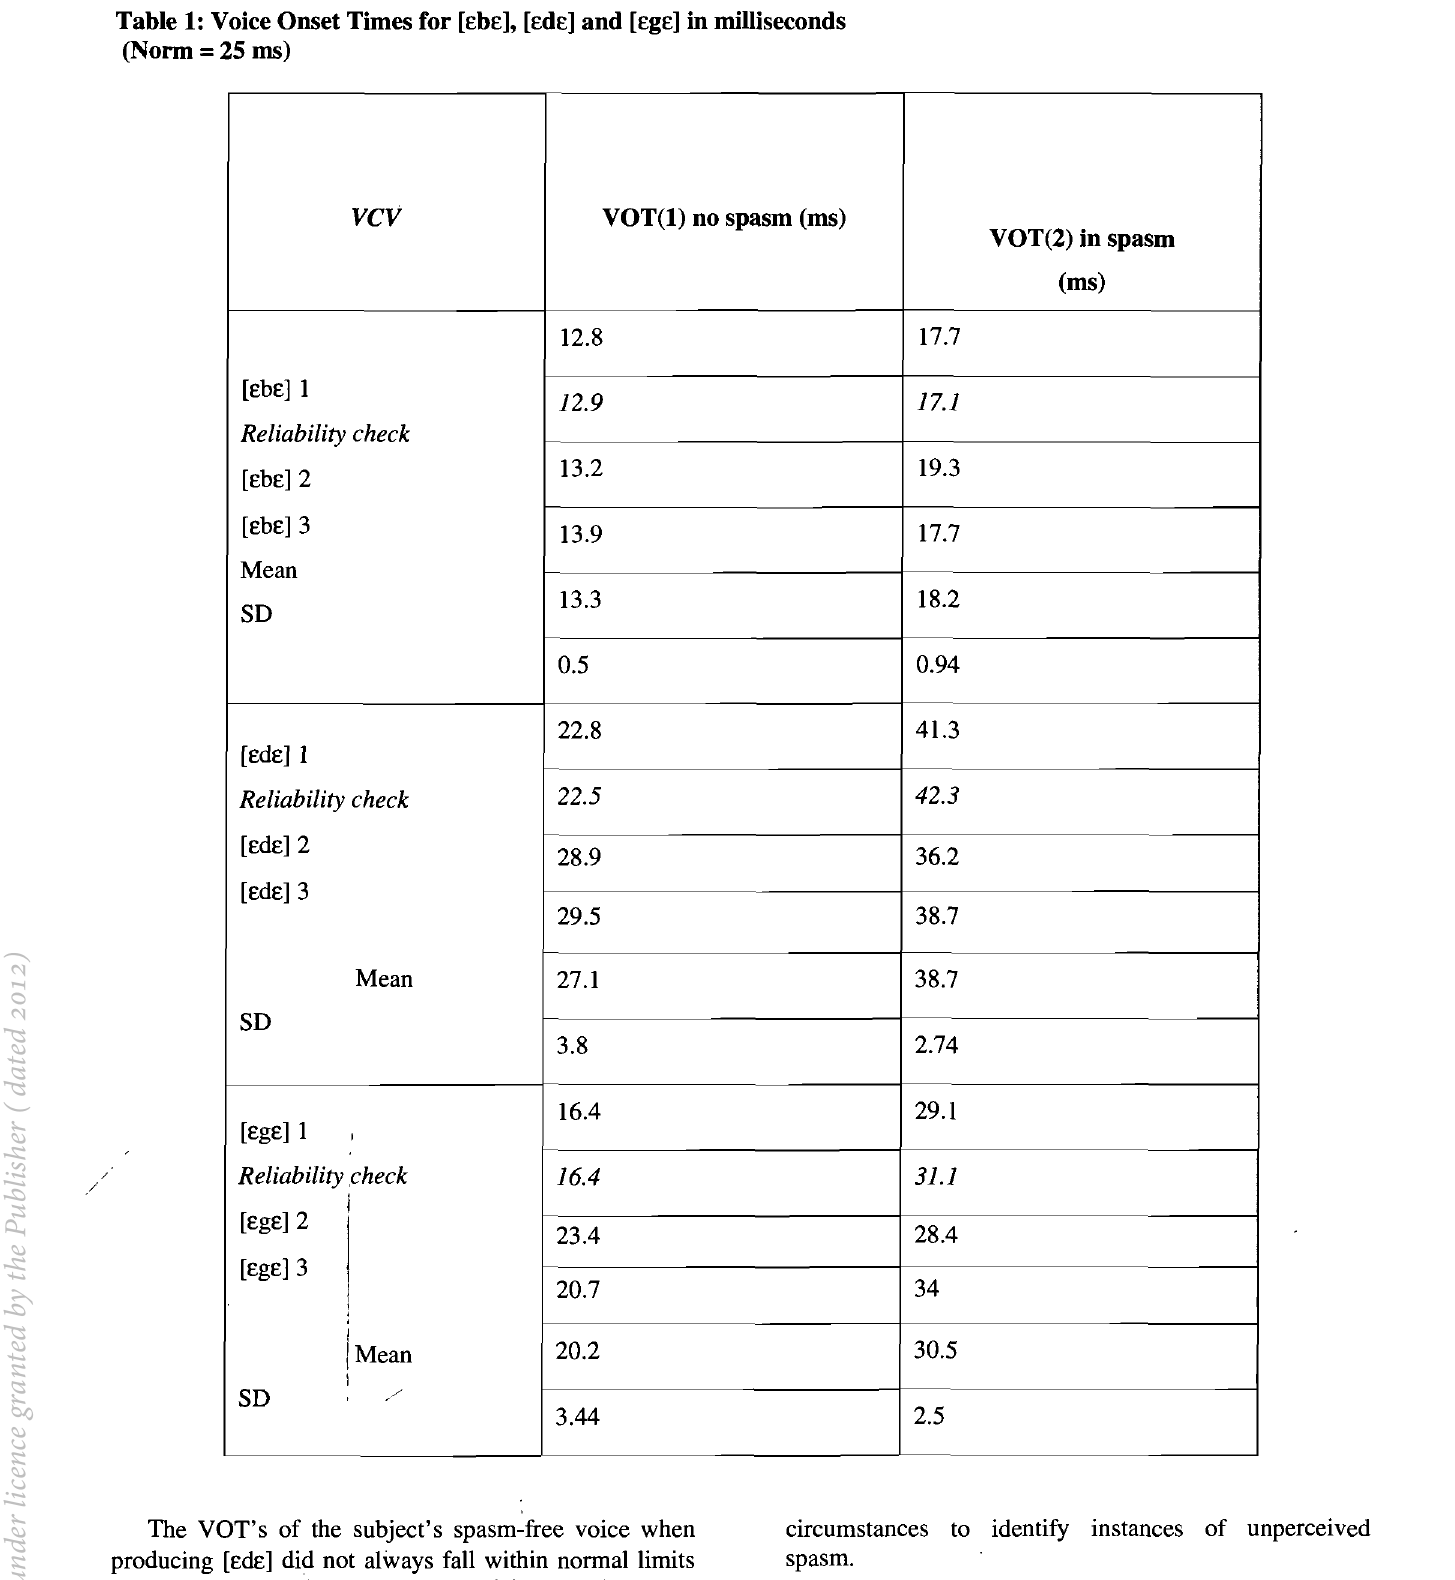
Table 1: Voice Onset Times for [EbE], [EdE] and [EgE] in milliseconds (Norm = 25